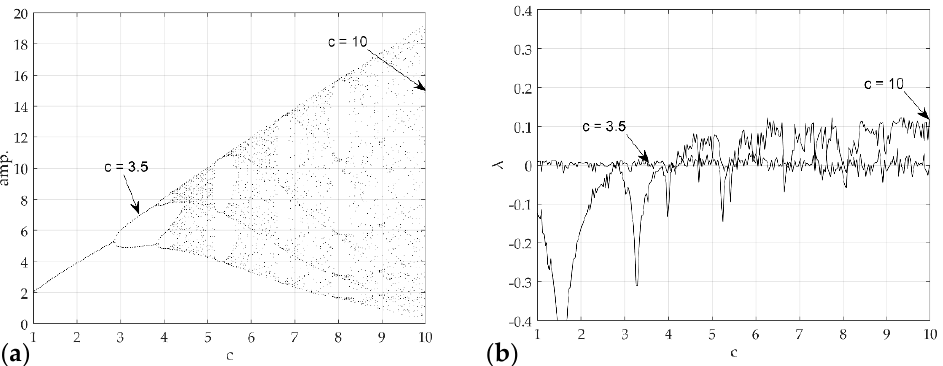
Figure 7. Chaotic analysis for Rossler model ( a ) bifurcation diagram of displacement ( b ) and largest Lyapunov exponent with respect to c .